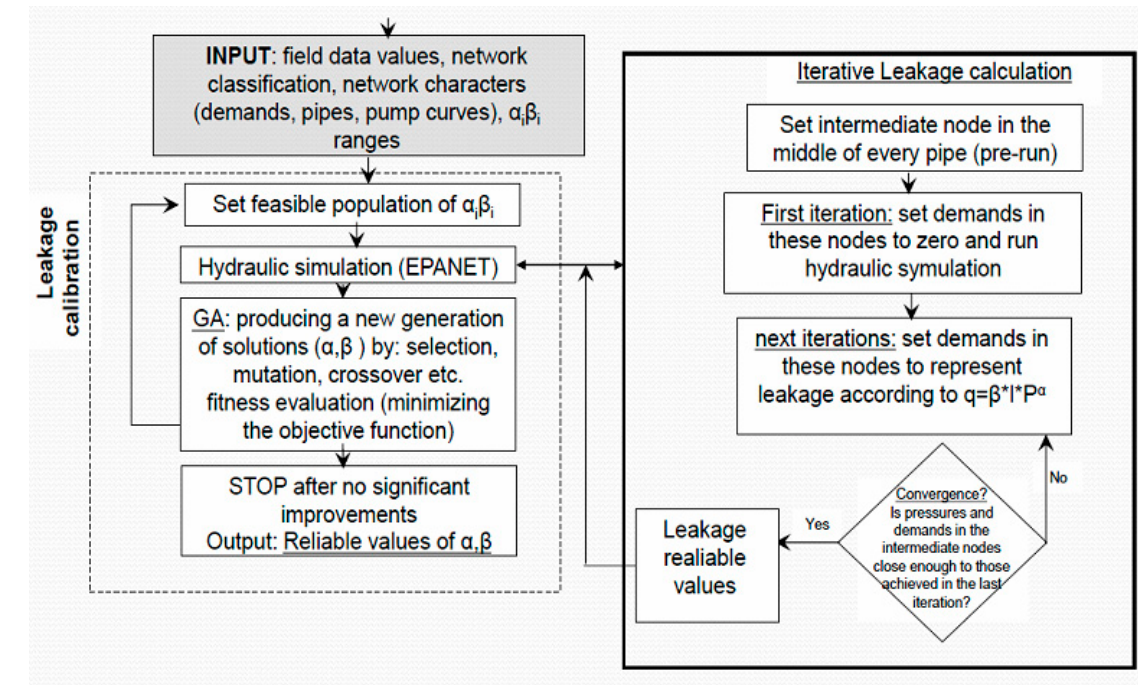
Figure 1. Methodology scheme of the calibration and calculation of the leakage.